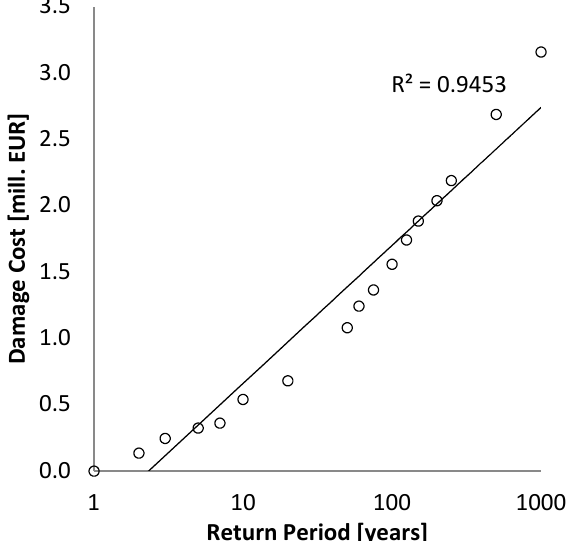
Figure 9. Log-linear relation between damage costs and the return period for the study area in Odense.